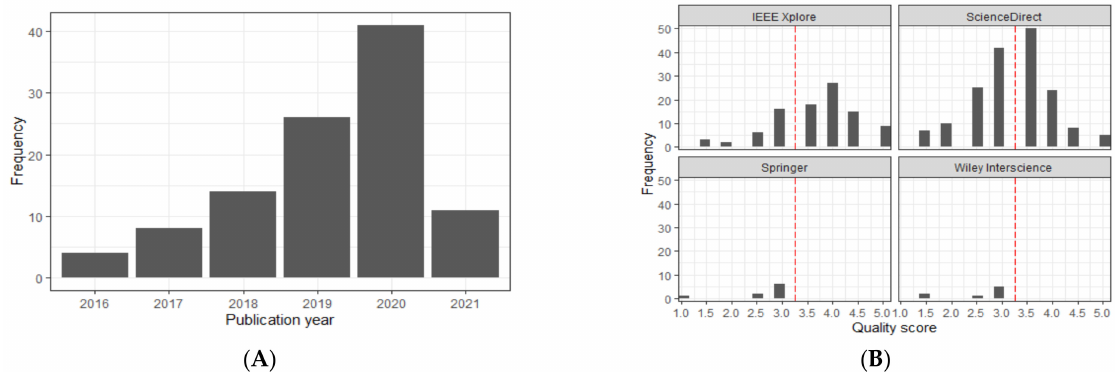
Figure 2. ( A ) : Search query hit frequencies for 5 year timespan (2016–2021). ( B ) : Quality score distribution per digital library. The red dash indicates inclusion cutoff at 3.5. Only journals with higher quality ranking than 3.5 were considered in the review.